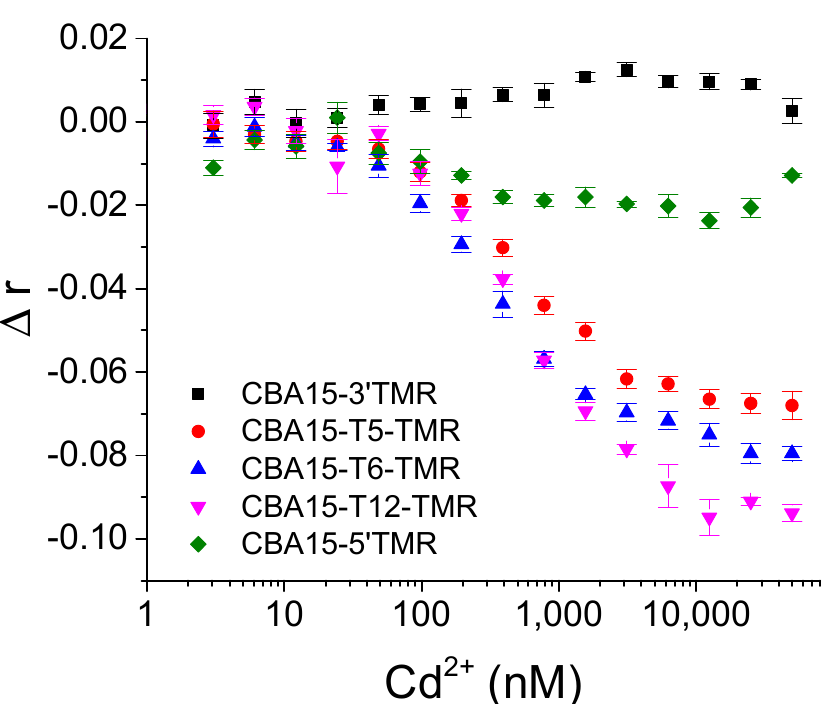
Figure 3. FA changes ( Δ r) of different TMR-labeled aptamers upon binding with various concentrations of Cd 2+ . Δ r was obtained by subtracting the FA values of blank samples from the FA values of various concentrations of Cd 2+ .